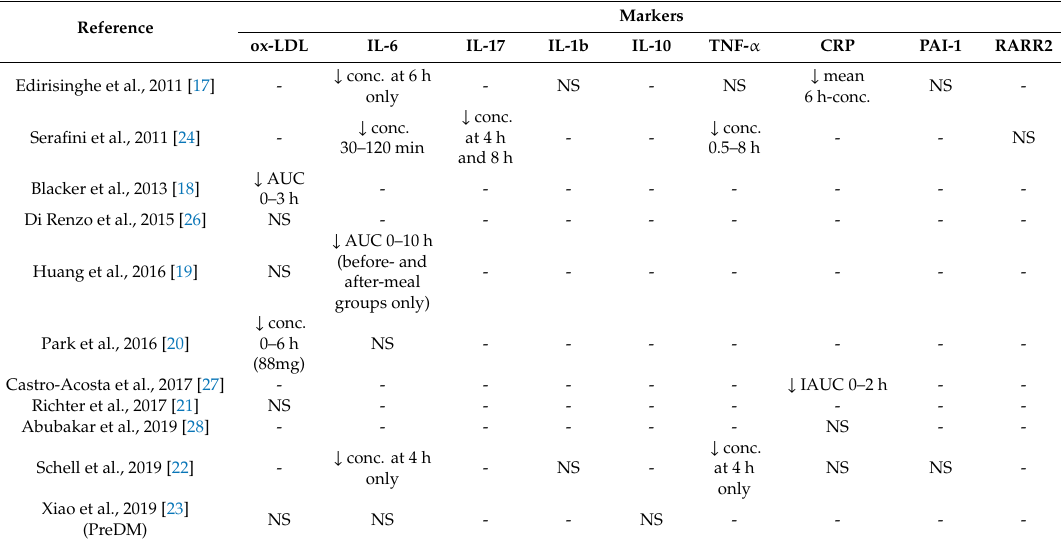
Table 6. E ff ects of anthocyanin intake in composite meals on inflammatory markers.